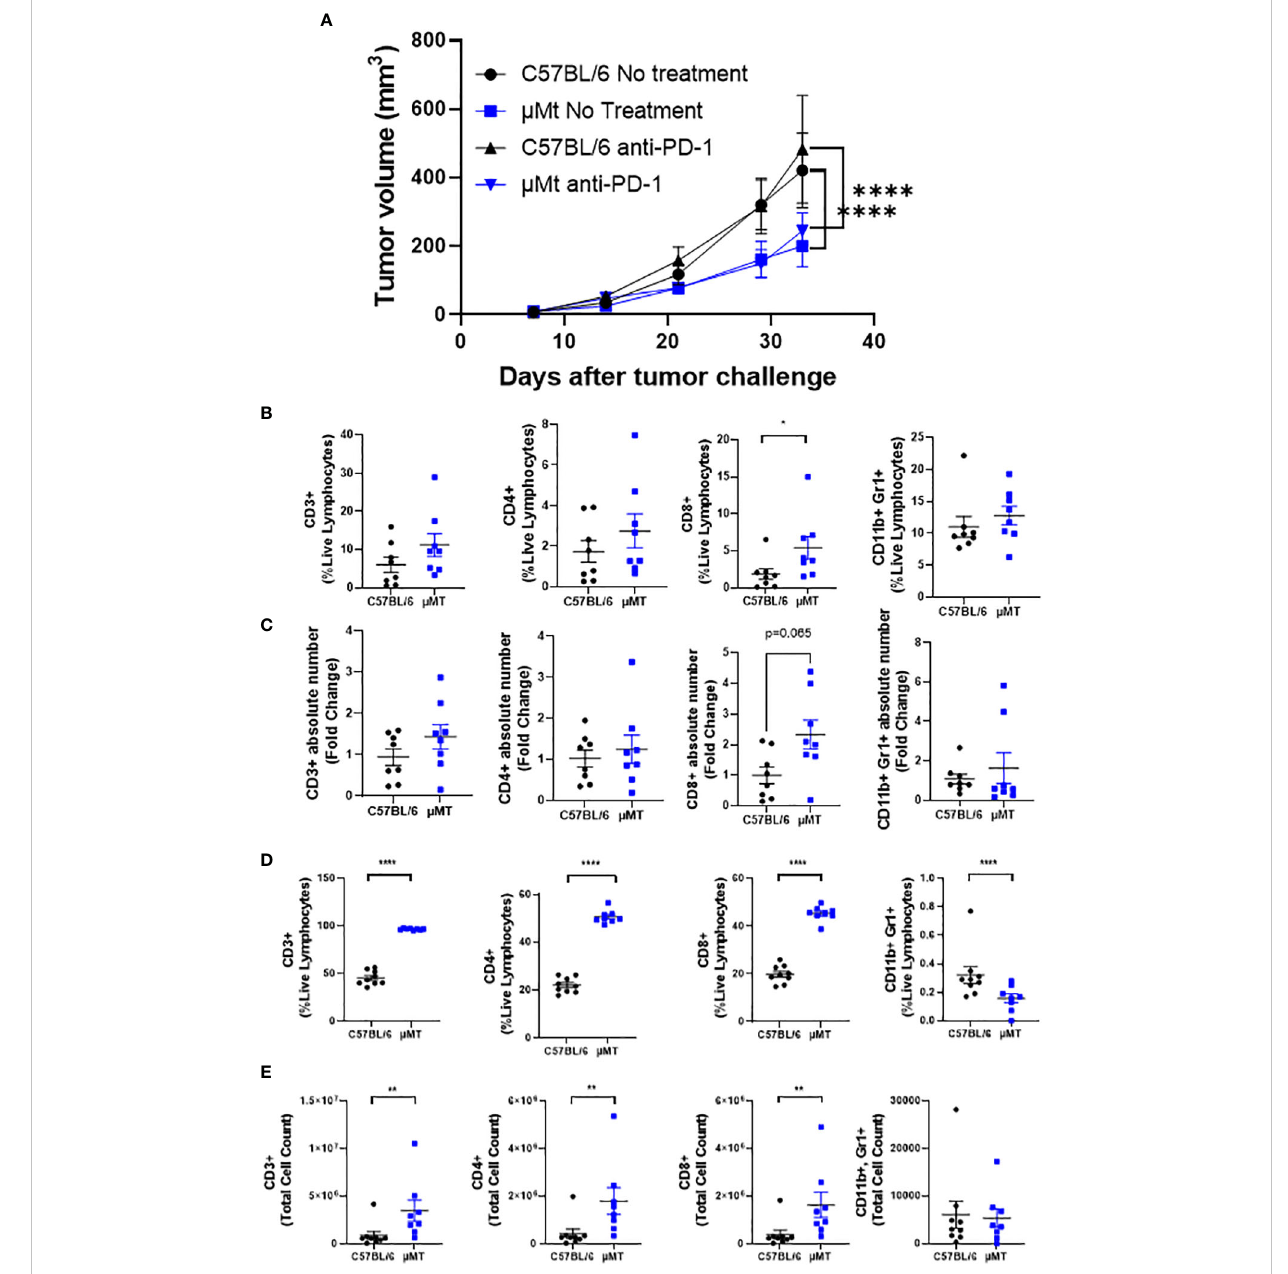
FIGURE 3 B cell de fi ciency delays the growth of HPV+ oropharyngeal subcutaneous tumors. C57BL/6 and µMT mice were injected subcutaneously with (1 x 10 6 ) mEER tumor cells and monitored for 33 days. Anti-PD-1 (250 µg) was given intraperitoneally on days 10, 13, and 16. Tumor volume was measured with a caliper once per week and twice after the third week. Graphs represent group means ± SEM (n = 9 – 10 mice/group) (A) . The percentage of CD3+, CD8+, CD4+, and CD11b+ Gr1+ cells between C57BL/6 and µMT mice were quanti fi ed in subcutaneous tumors at day 33 after tumor implantation by fl ow cytometry (B) . The fold changes of the TIL counts compared to C57BL/6 were calculated (C) . The percentage (D) and cell counts (E) of CD3+, CD8+, CD4+, and CD11b+ Gr1+ cells between C57BL/6 and µMT mice were quanti fi ed in tumor-draining lymph nodes. A Mann-Whitney test was performed *p < 0.05, **p < 0.005, ****p < 0.00005. Results depict pooled data from 2